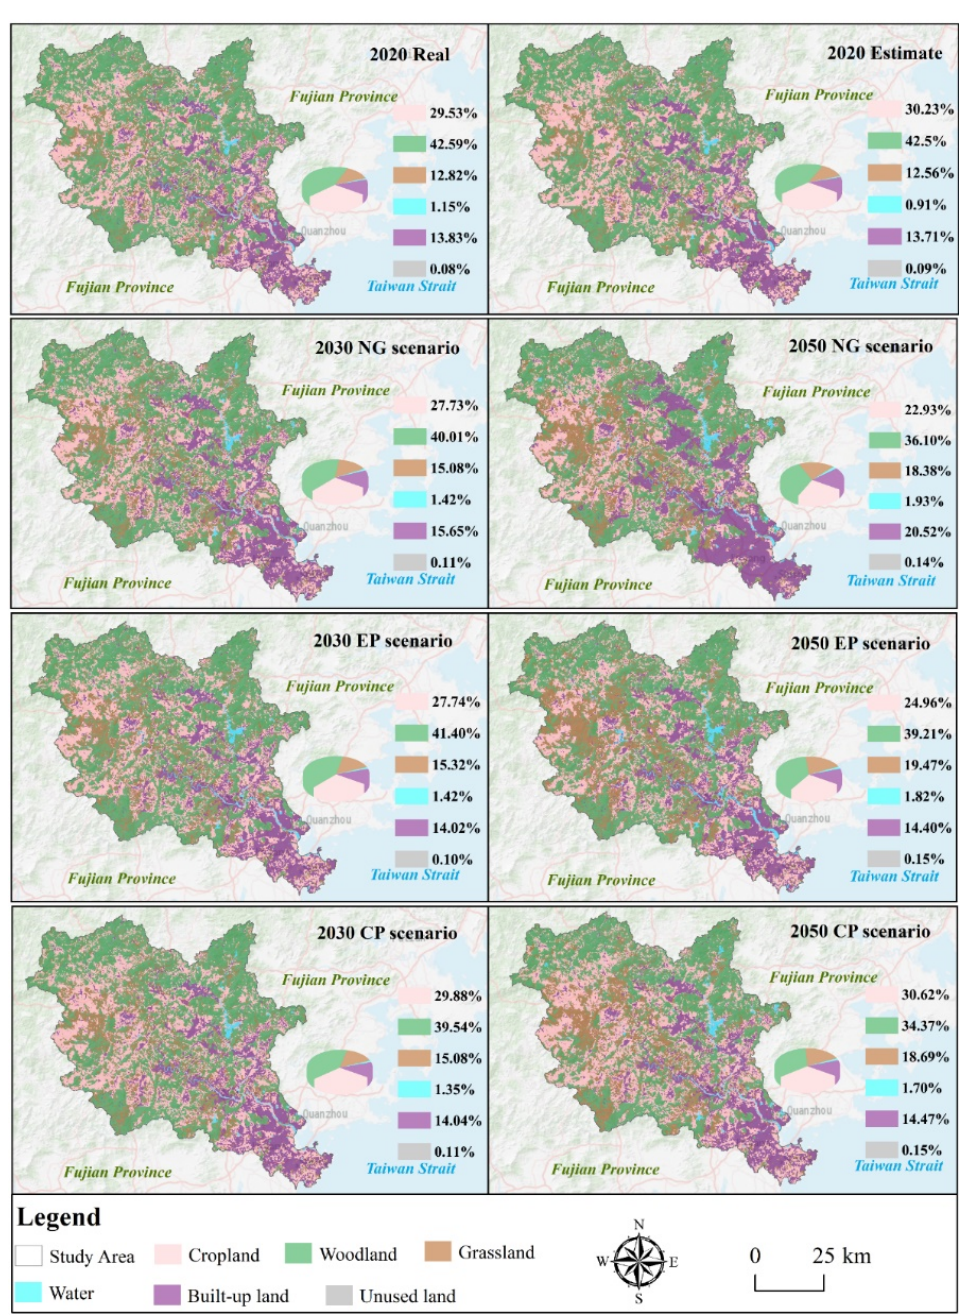
Figure 5. Land-use simulation results under the three scenarios in 2030 and